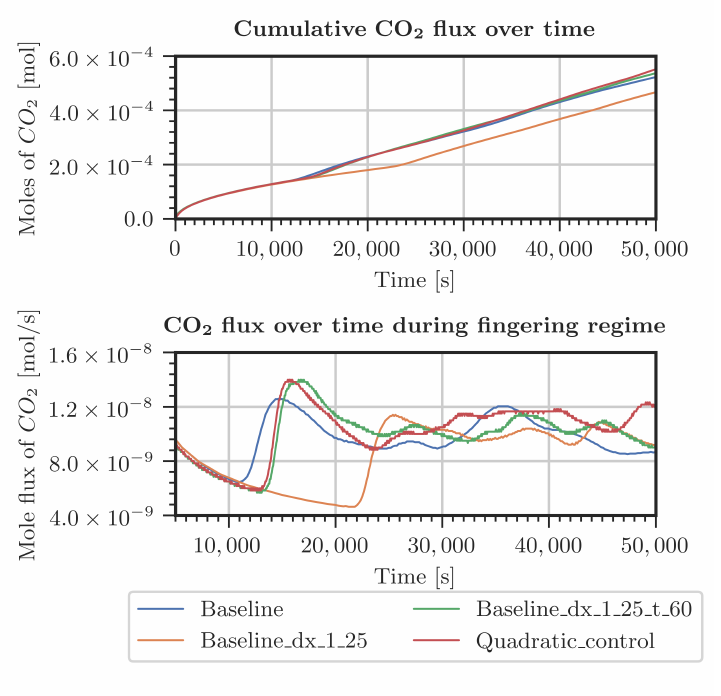
Figure A2. Comparison of CO 2 entering the system for various grids (Table A1). Constant pressure and CO 2 concentration at the top